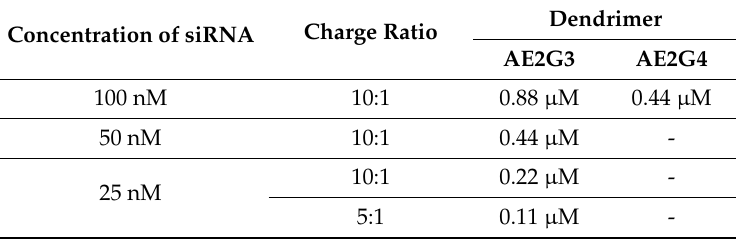
Table 1. Final concentrations of dendrimers used for delivery of siRNAs.